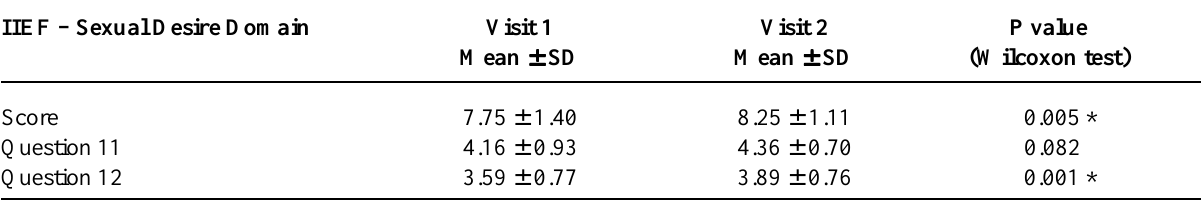
Table 1 – Score and questions related to the sexual desire domain of the IIEF on visits 1 and 2 (n = 64).